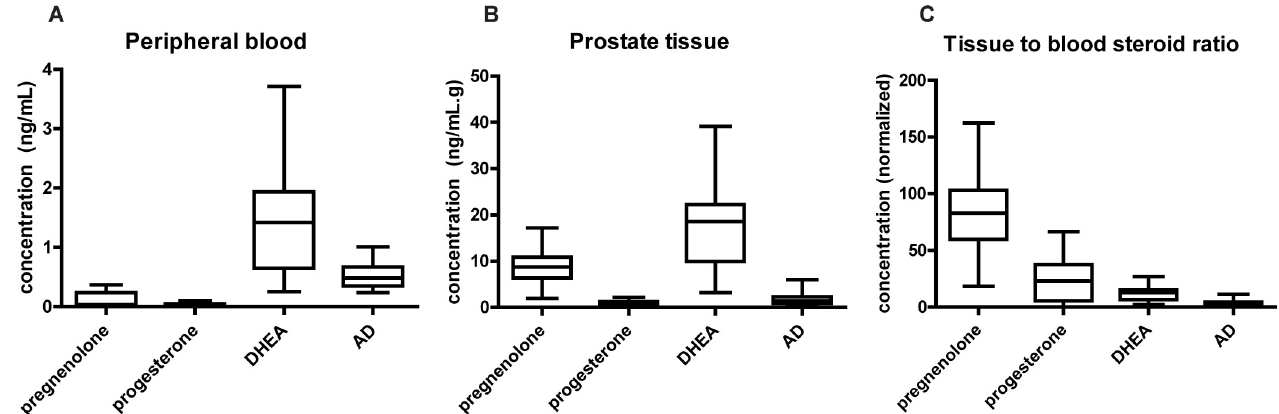
Fig 6. Preferential accumulation of progestogens and 3 β -OH, Δ 5 -steroids is observed in human prostate tissue. Box and whisker plots of (A) blood concentrations, (B) normal prostate tissue concentrations, and (C) tissue to blood concentration ratios (tissue concentrations normalized to mean blood concentrations) for four steroids using samples from twenty prostate cancer patients. Prostatic tissue was collected at the same time as peripheral blood in patients undergoing radical prostatectomy. The ratio for pregnenolone was larger than the ratios for all other steroids; the ratio for progesterone was larger than the ratio for AD and the ratio for DHEA was larger than the ratio for AD (two-tailed Mann-Whitney U tests after Kruskal-Wallis test, p < 0.001 for all comparisons).